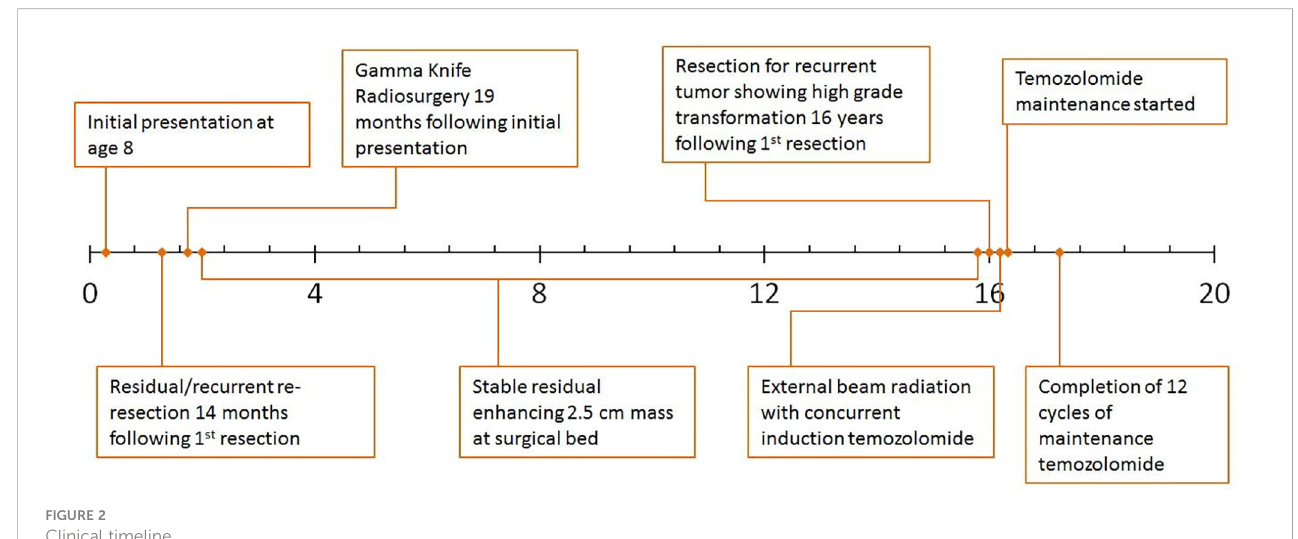
FIGURE 2 Clinical timeline.